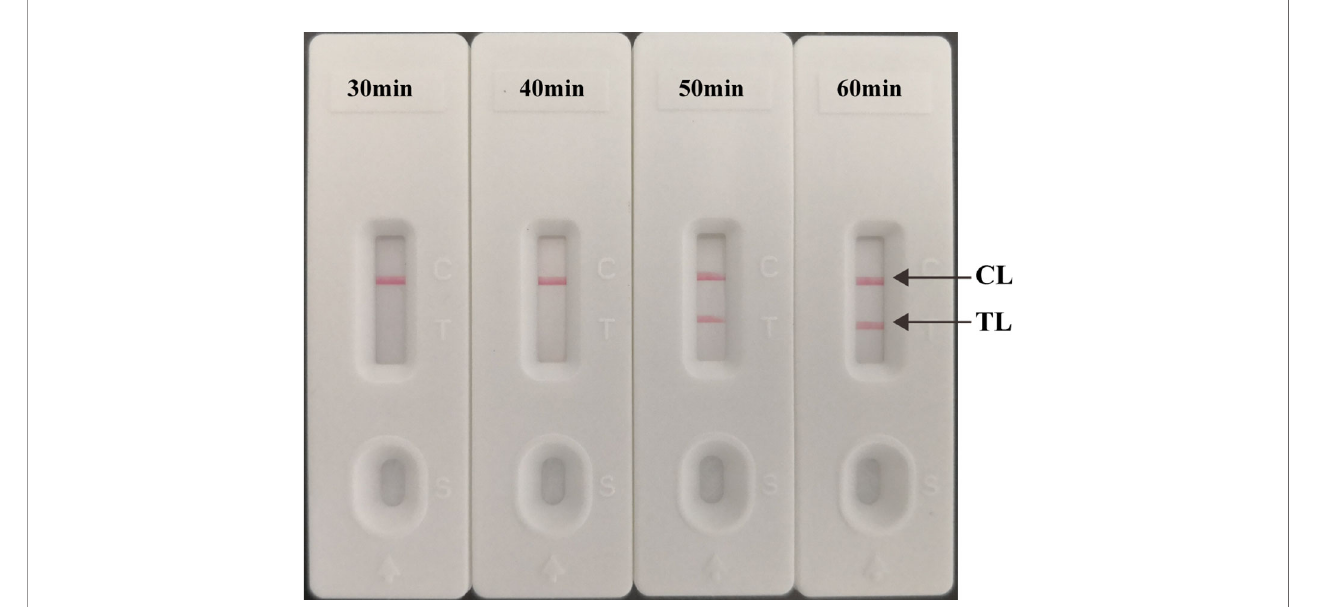
FIGURE 6 | Optimized reaction Time for multiplex LAMP-LFB Assay. The LAMP reactions with template at the LoD level (10 fg) were ampli fi ed at 30 min, 40 min, 50 min, and 60 min at the optimal temperature (66°C).